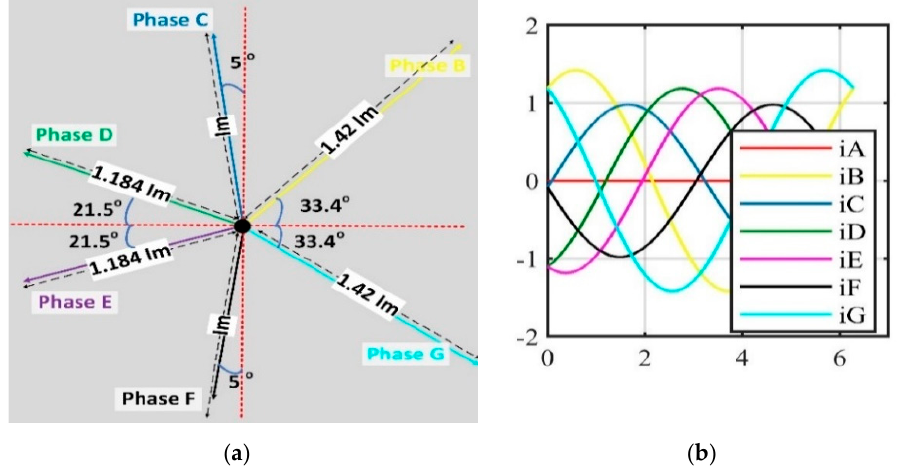
Figure 6. Current distribution of seven ‐ phase motor under minimizing copper losses optimization. ( a ) Phasor; ( b ) sinusoidal.